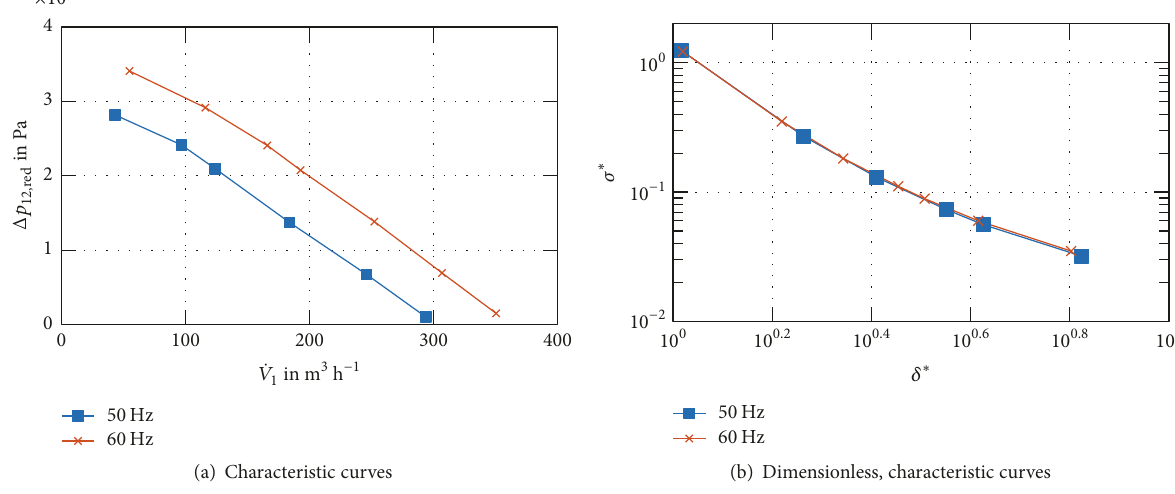
Figure 8: Aerodynamic characteristics of the side channel blower under